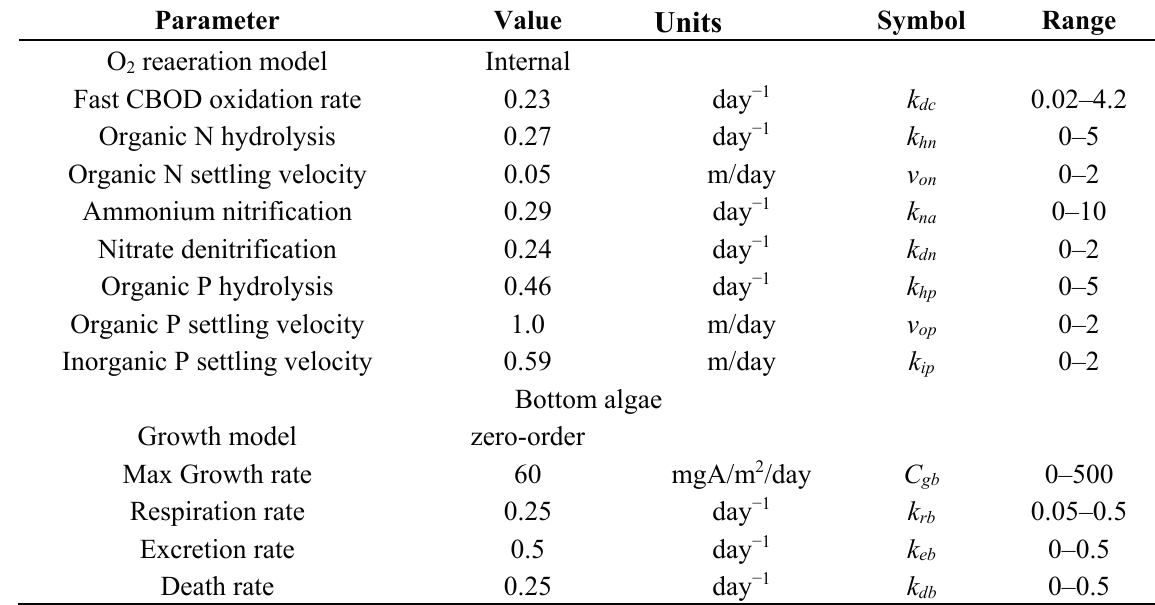
Table 6. Calibrated parameters for the Wujin River water quality